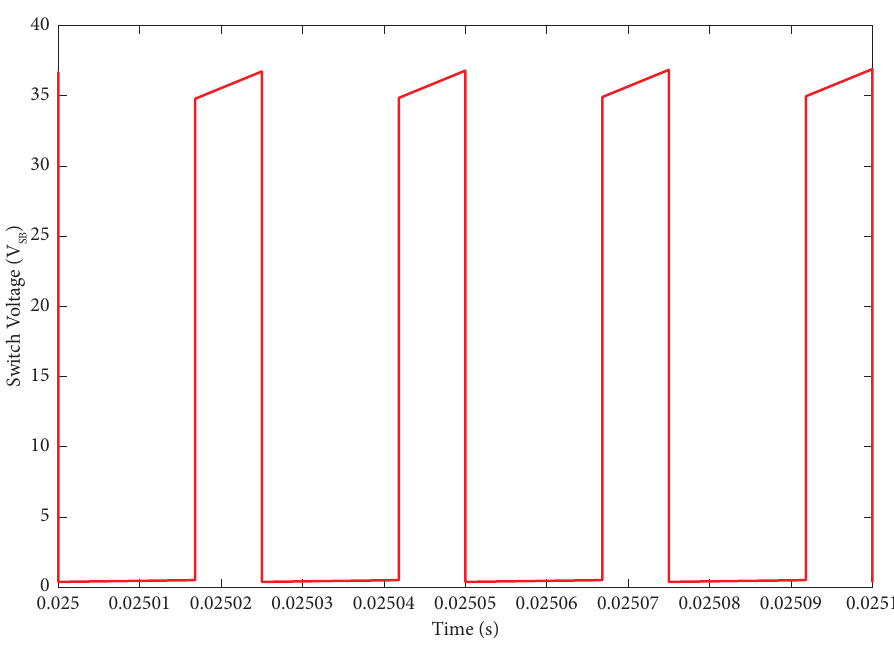
Figure 11: Te switch S B simulated voltage